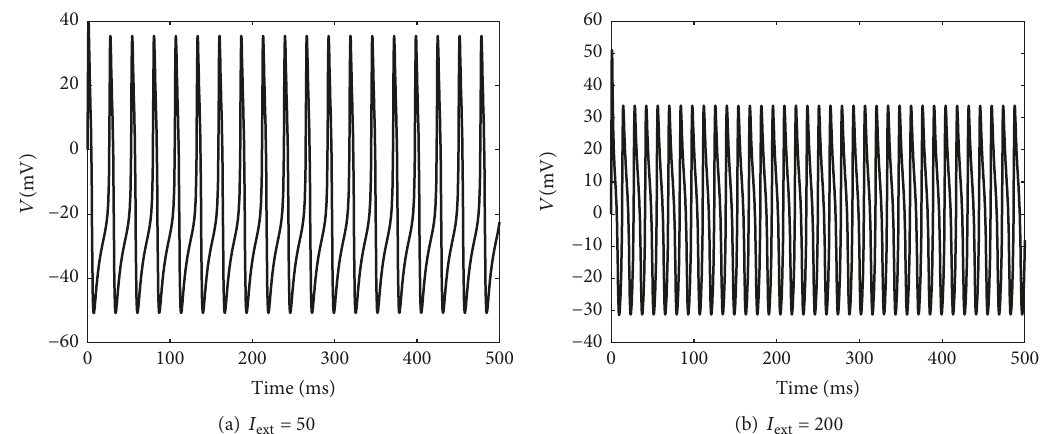
Figure 1: Membrane potential of a Morris-Lecar neuron when 𝐼 ext are